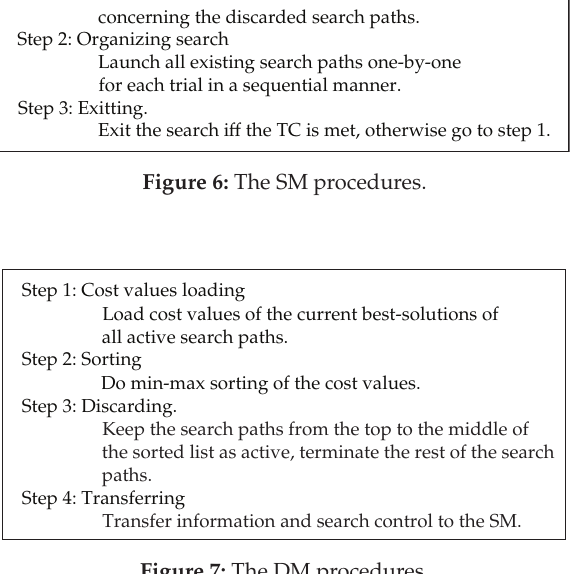
Figure 7: The DM